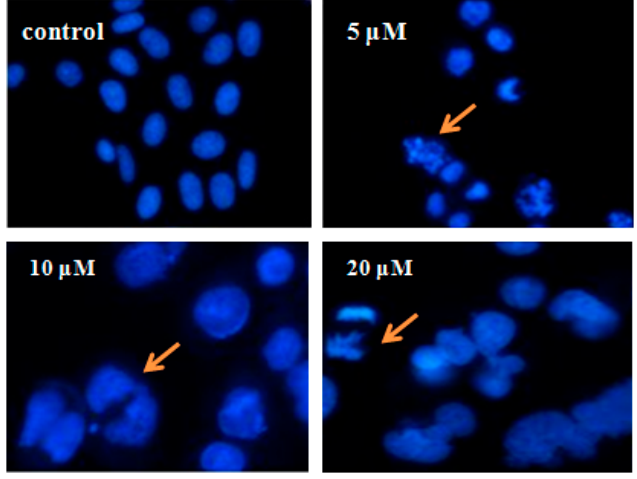
Figure 5. Apoptosis analysis with Hoechst-33258 staining after a 48 h treatment of I-21 in SK-N-SH cell line at 5 μ M, 10 μ M and 20 μ M.